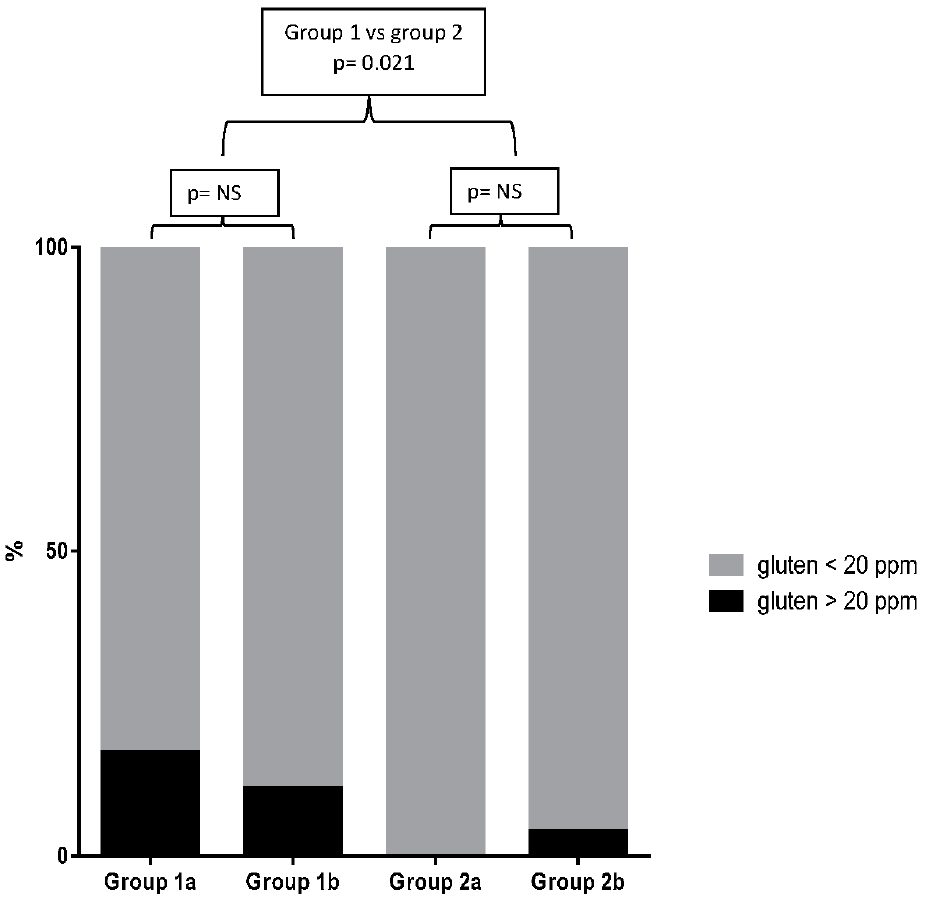
Figure 3. Percentage of contaminated products in each food group.